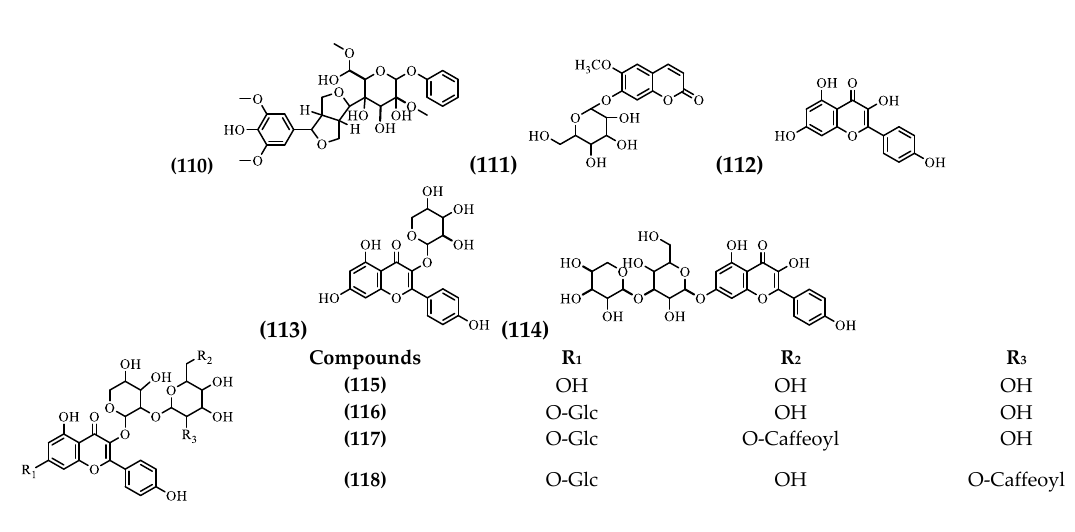
Figure 6. Structure of Steroids from Brugmansia suaveolens. Table 5. Steroids from Brugmansia suaveolens .